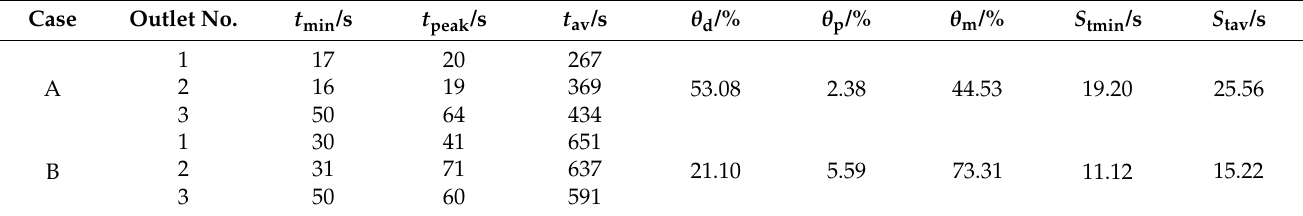
Figure 2. Retaining wall structure ( a ) and vortex inhibitor ( b ) in optimized case B and their geometry sizes, unit: mm. Table 6. Flow characteristic parameters of the two experimental